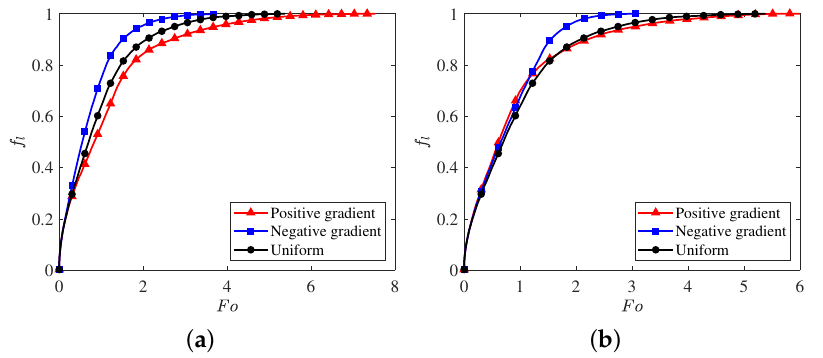
Figure 3. Comparisons of liquid fraction f l in three gradient structures for ( a ) case A and ( b ) case B at Ra = 10 6 , in which Ste = 0.1, and Pr =